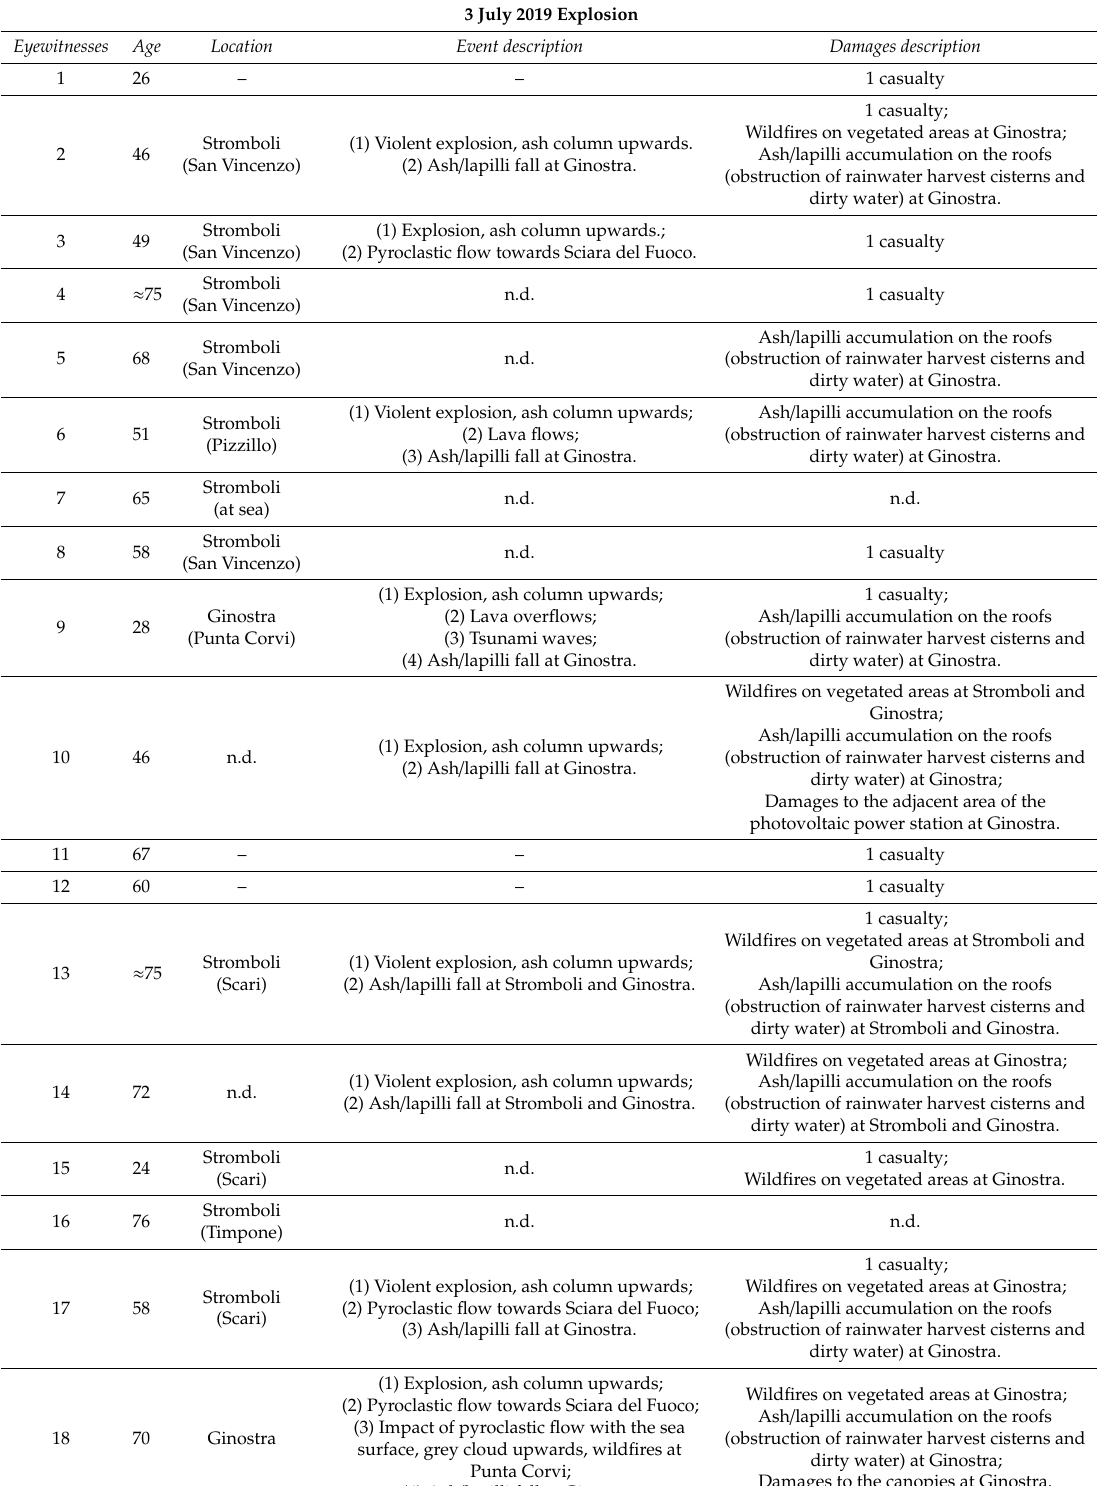
Table A2. Summary of semi-structured interviews to the inhabitants of Stromboli island, after the 3 July 2019